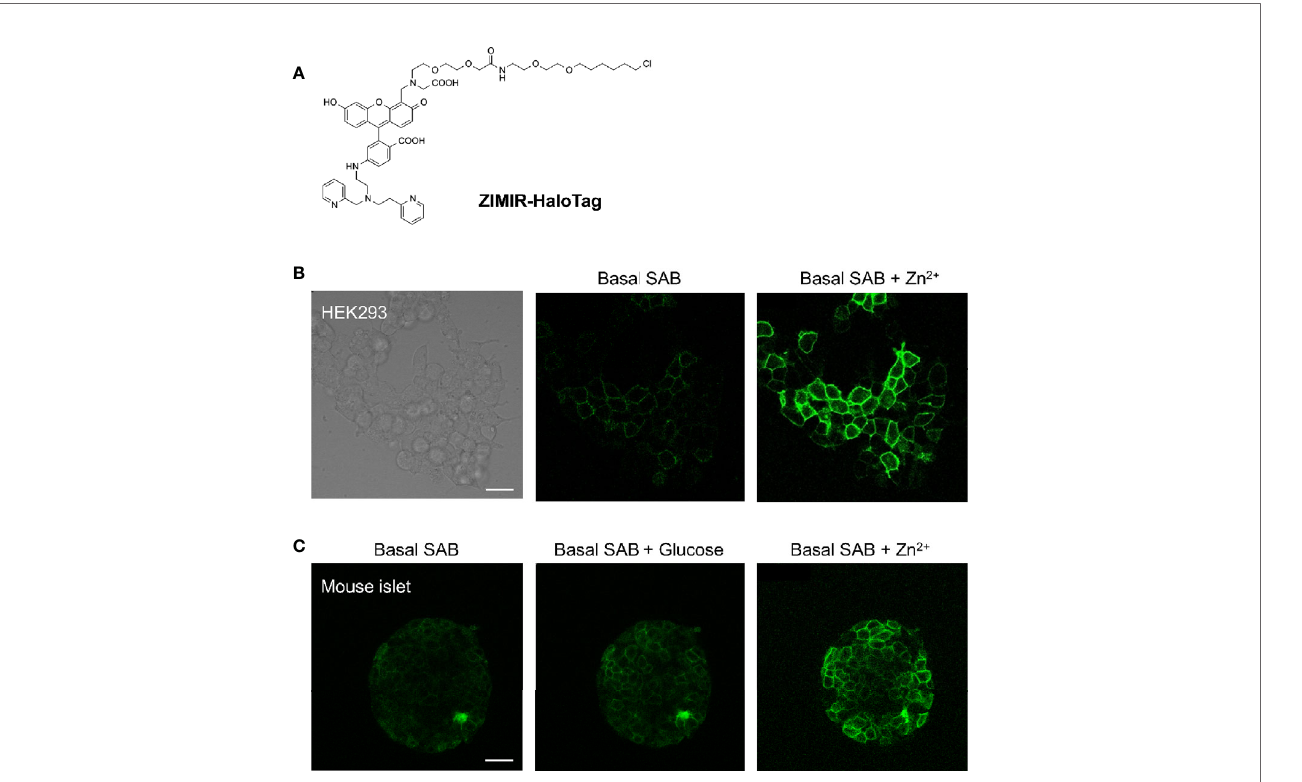
FIGURE 6 | Imaging insulin/Zn 2+ secretion in isolated mouse islets with ZIMIR-HaloTag. (A) Chemical structure of ZIMIR-HaloTag. (B) ZIMIR-HaloTag labeled the plasma membrane of HEK293 cells expressing pDisplay-HaloTag and responded to Zn 2+ elevation in the medium. (C) Confocal imaging of insulin/Zn 2+ secretion in an isolated islet from a MIP-rtTA::TRE-pDisplay-HaloTag-Myc mouse (doxycycline induced). The islet was labeled with ZIMIR-HaloTag (2 µM for 30 min) in vitro . After glucose challenge, a high Zn 2+ buffer (1 µM Zn 2+ ) was added. Scale bar = 20